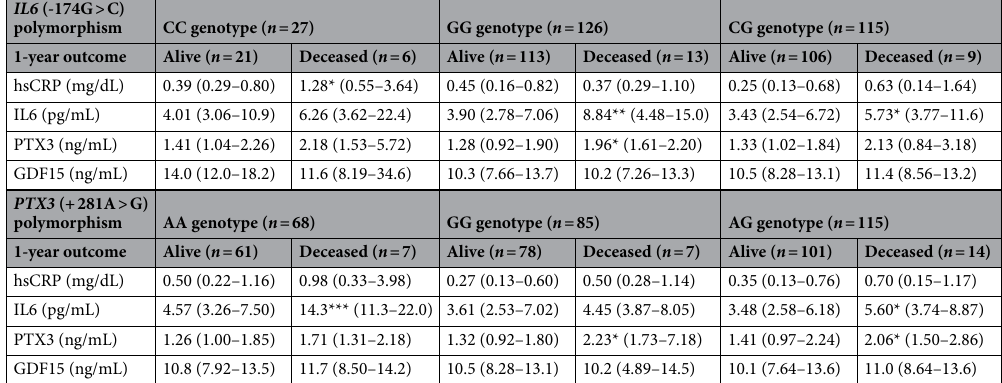
Table 7. Blood levels of IL6, hsCRP, PTX3 and GDF15 according to the IL6 (rs1800795) and PTX3 (rs2305619) single nucleotide polymorphisms in alive and deceased end-stage renal disease patients. Data are presented as median (interquartile range). Multiple comparisons between genotypes were performed by the Mann–Whitney U test. * p < 0.050. ** p < 0.01 alive versus deceased. GDF15 growth differentiation factor 15, hsCRP high-sensitivity C-reactive protein, IL6 interleukin 6, PTX3 pentraxin 3.